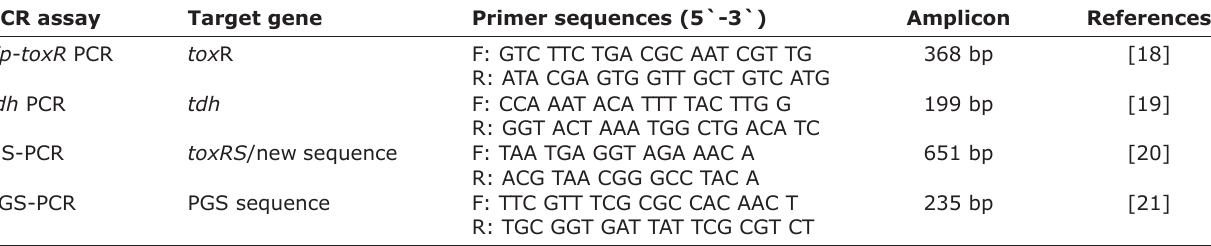
Table-2: Oligonucleotide primers used in different PCR assays. PCR assay